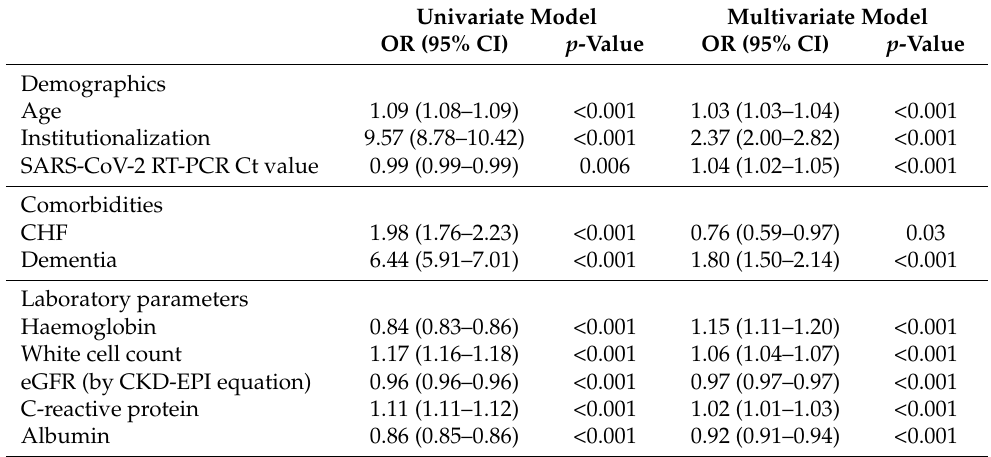
Table 4. Predictors for hypernatraemia at presentation in patients with